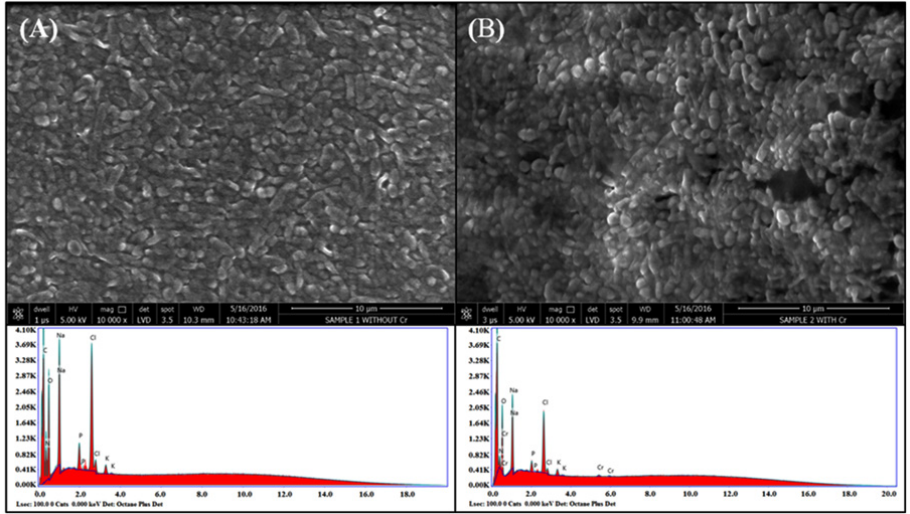
Fig. 4. (A) SEM-EDAX images of SN6 without Cr(VI); (B) SEM-EDAX images of Cr(VI) treated